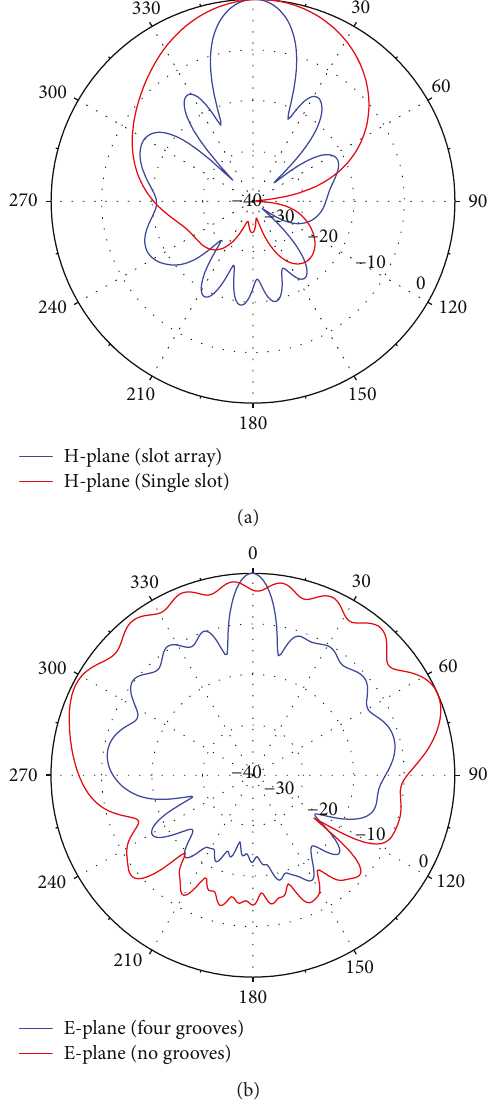
Figure 3: Radiation pattern comparisons between (a) the slot- array-based and single-slot-based SIW corrugated antennas and (b) slot-array-based SIW corrugated antenna and slot array antenna on a fl at surface.